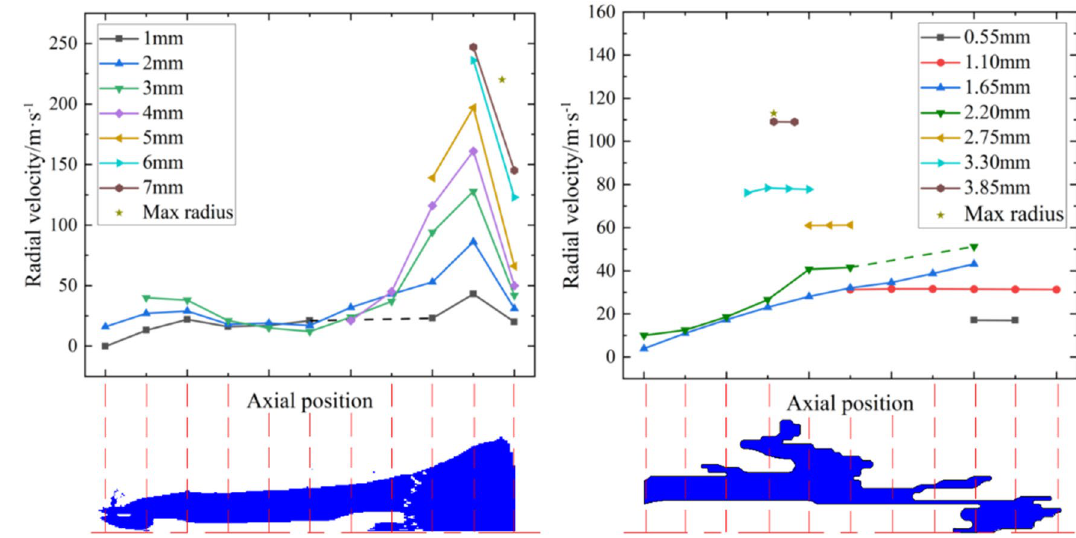
Figure 10. Radial velocities at different positions of the jet tip and tail at 30 μs (Left: radial velocity of region A; Right: radial velocity of region